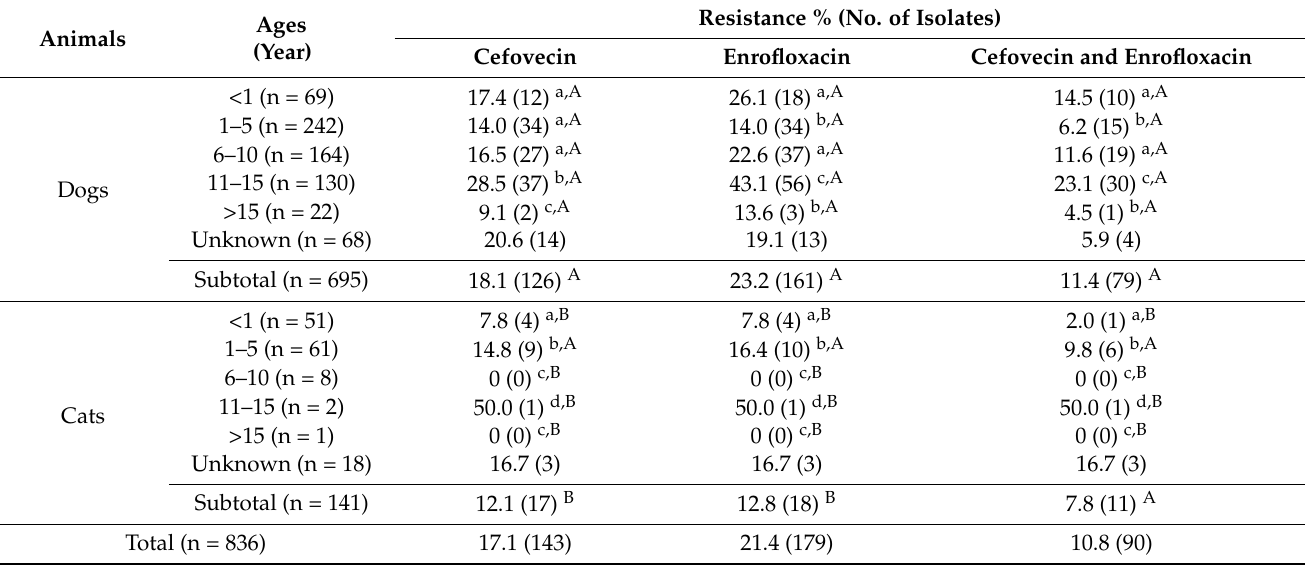
Table 2. Distribution of cefovecin- and enrofloxacin-resistant E. coli among different age groups of diseased dogs and cats.